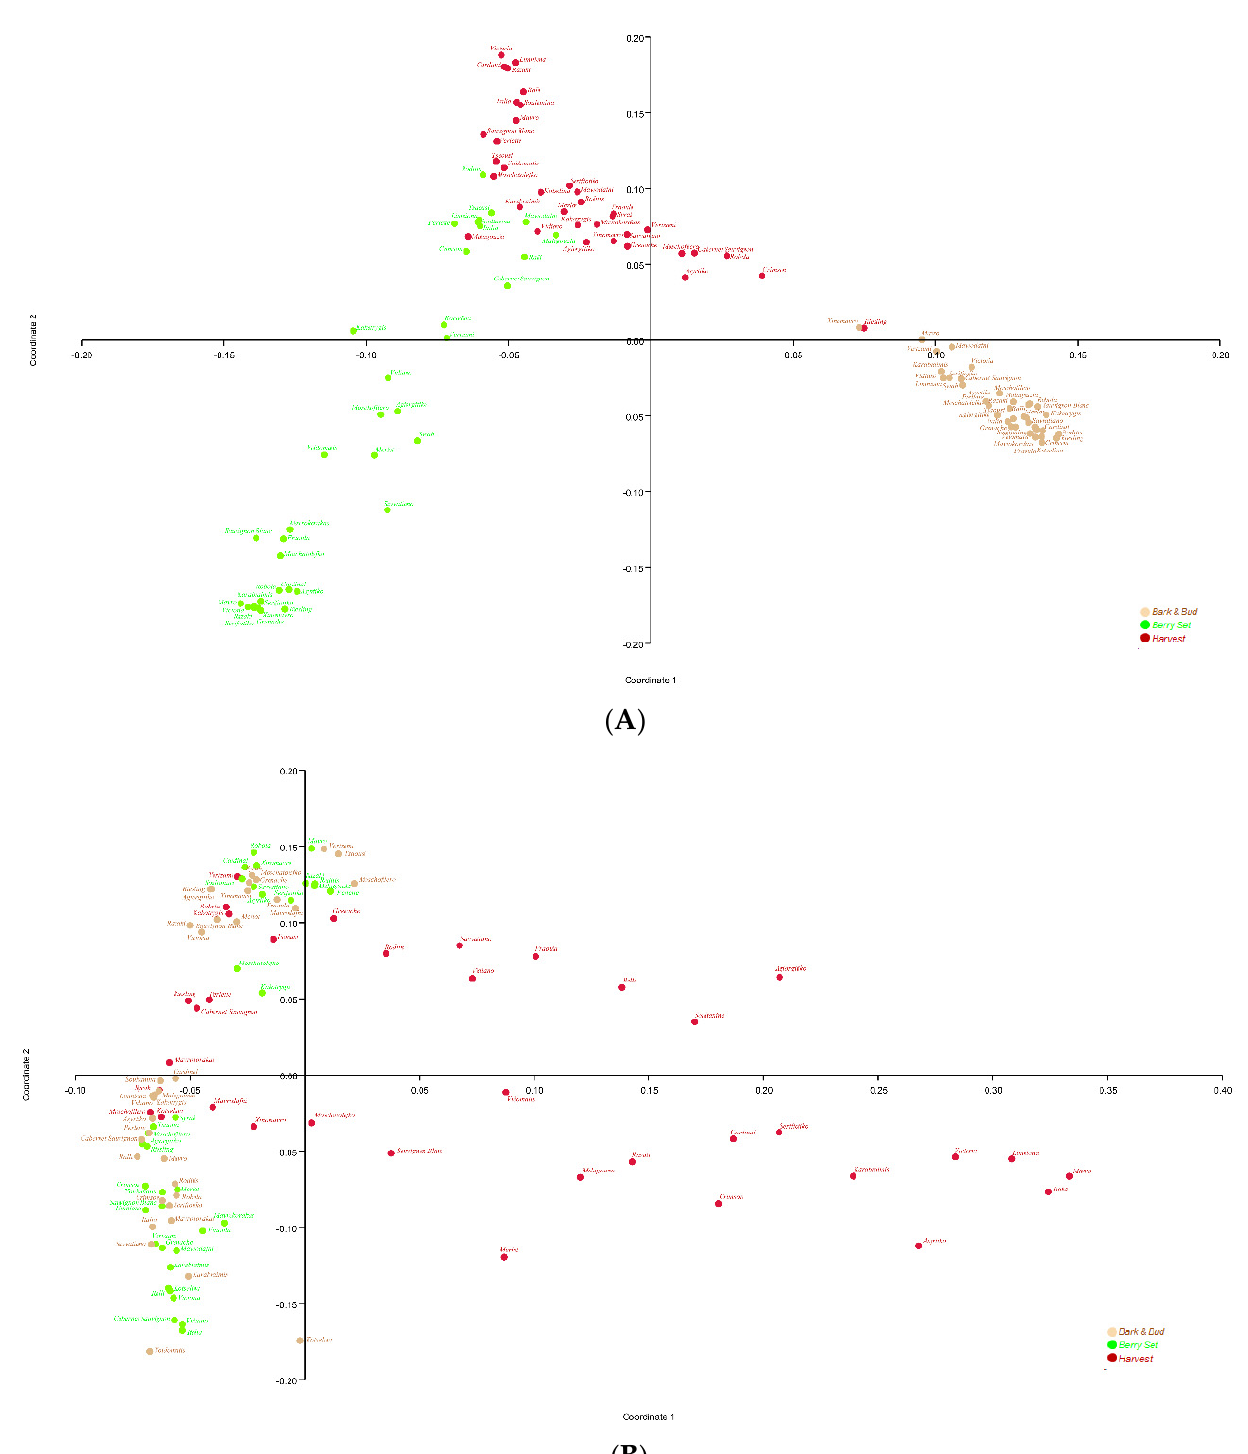
Figure 3. Bray-Curtis distance PCoA of bacterial ( A ) and fungal ( B ) genera for the three phenological stages for 36 grapevines. Table 3. Factors predicting α - and β -diversity on microbial communities in the vineyard.